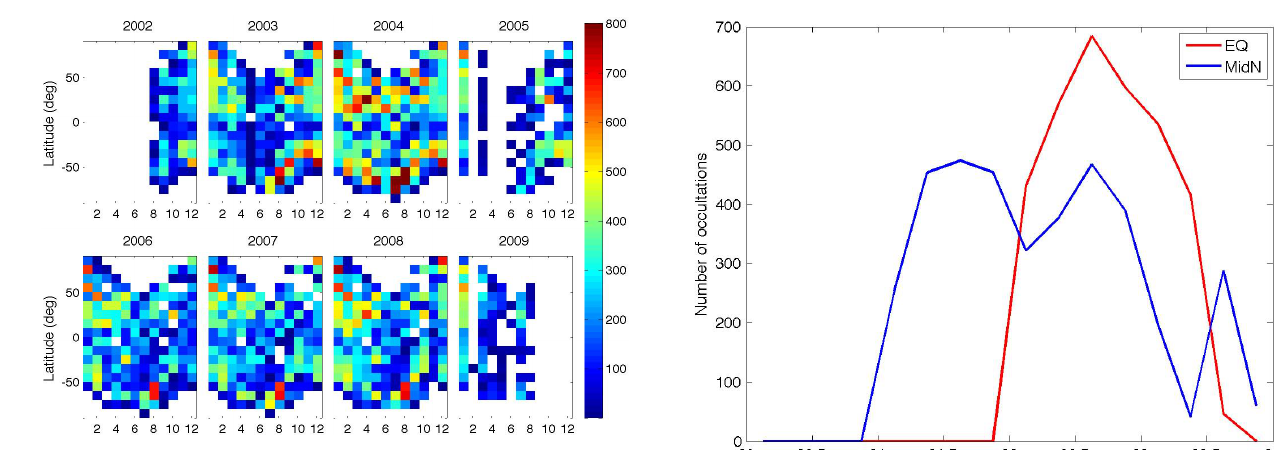
Fig. 1. Monthly number of dark limb occultations (solar zenith angle greater than 107 ◦ ) in 28 August 2002–8 August 2009 as a function of time and latitude. Measurements have been collected monthly to the 10 ◦ latitudinal grid. Occultations that have ended be- fore the 20km tangent height or that have the obliquity angle larger than 80 ◦ have been disregarded. The grid cells that have fewer than 2 measurements carry white colour.